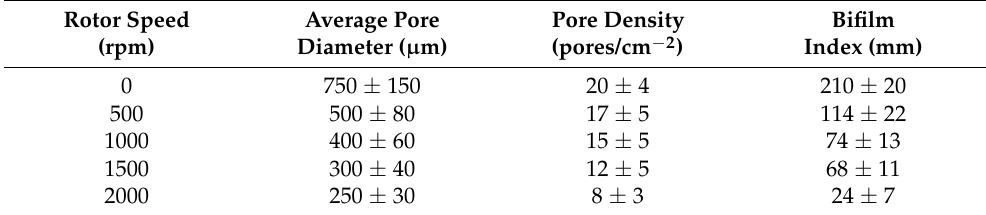
Table 2. Analysis of the porosity in RPT samples collected and solidified under partial vacuum during the in-line HSMC degassing process at a melt flow rate of 2 kg/min. Analysis of samples from